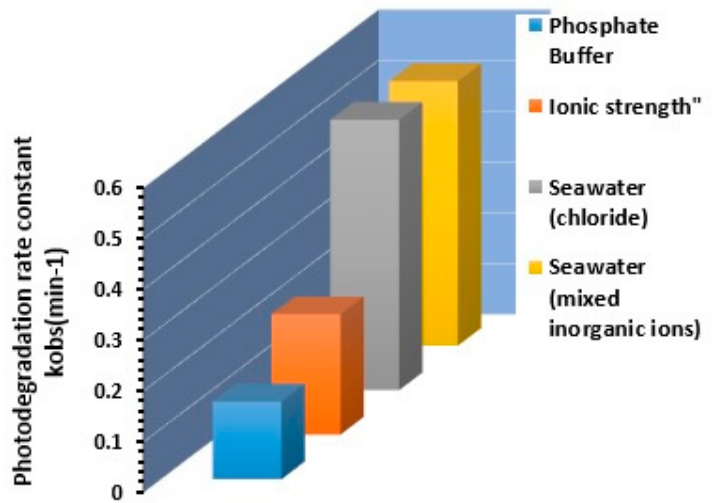
Figure 13. Effect of seawater constituents on photodegradation rate in synthetic matrices of 2,4-DCP at initial concentration of 5 mg/L, compared to seawater chlorine 680 mM.